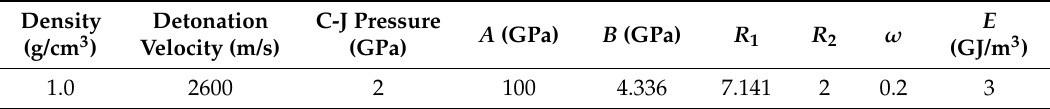
Table 3. Jones–Wilkins–Lee (JWL) coefficients and C-J parameters of expanded ammonium nitrate